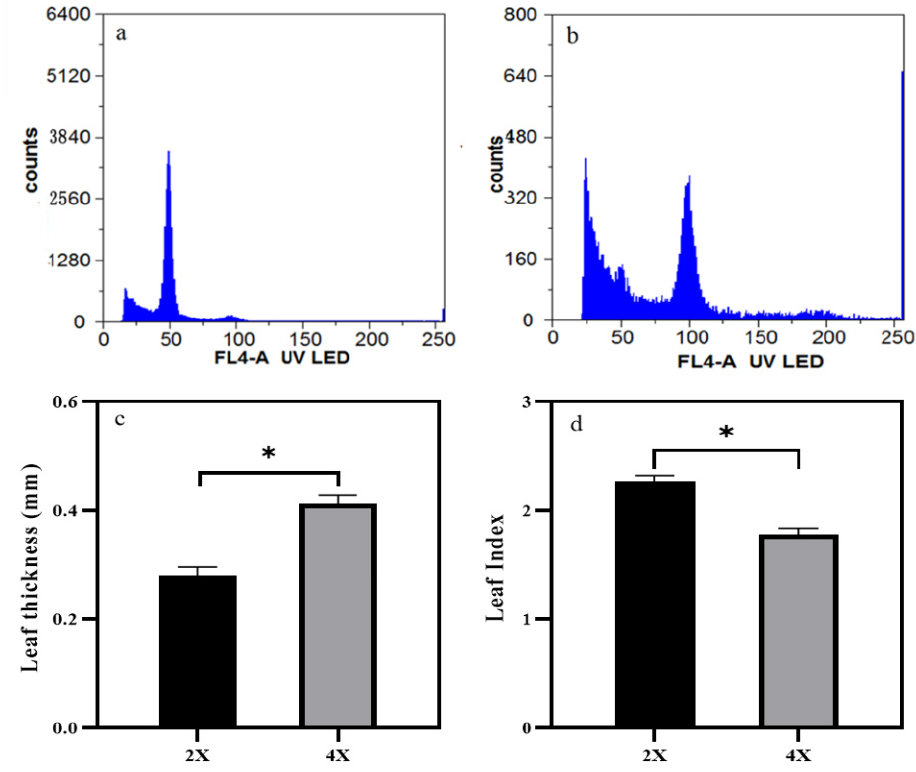
Figure 1. Ploidy analysis and comparison of the shape of leaf cells. ( a ) Normal diploid (2X) cell; ( b ) natural tetraploid (4X) cell; ( c ) leaf index; ( d ) leaf thickness in diploid and tetraploid leaves. * was the significance determined at p < 0.01 (n = 10).